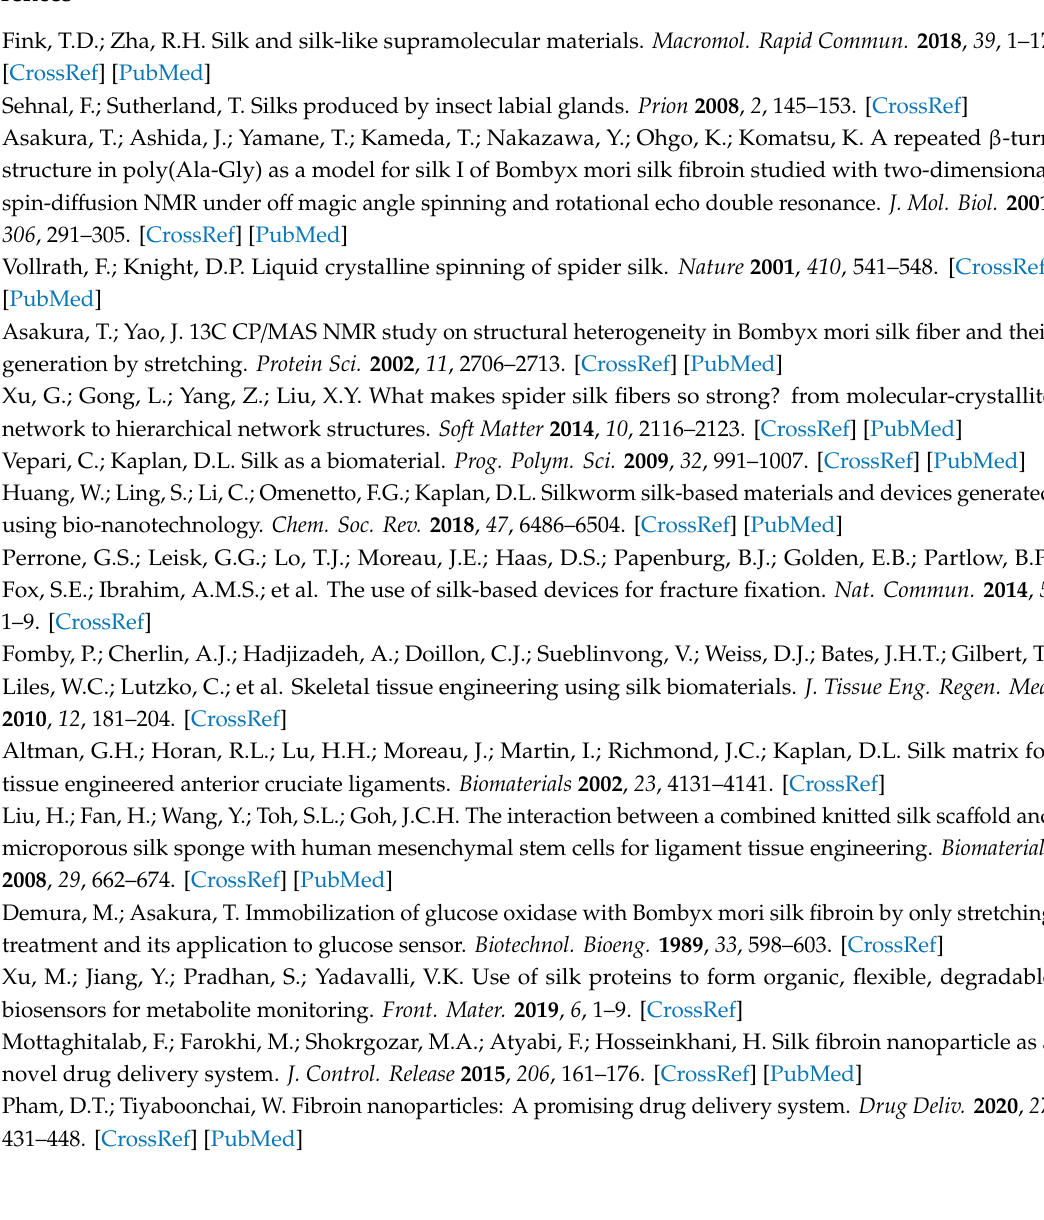
Figure S1: ATR-FTIR spectra of SF-EmimAc, SF-EmimAc / H 2 O, SF-EmimAc / D 2 O and the resultant spectrum of SF after subtracting solvent absorption using di ff erent subtraction